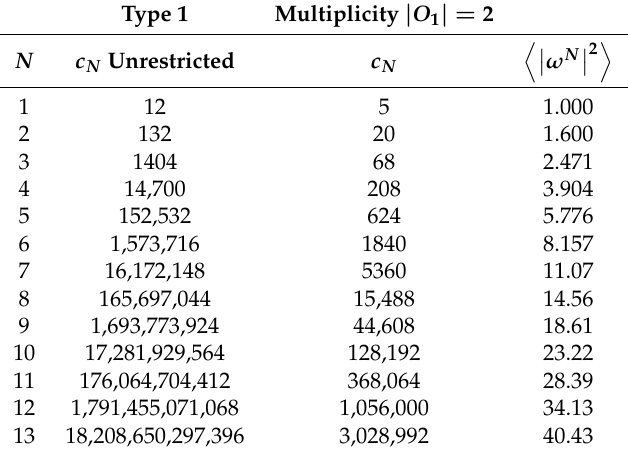
Table A4. FCC lattice, tube cross section 0.5 value of c N for SAWs on the unrestricted FCC lattice, included for comparison purposes.